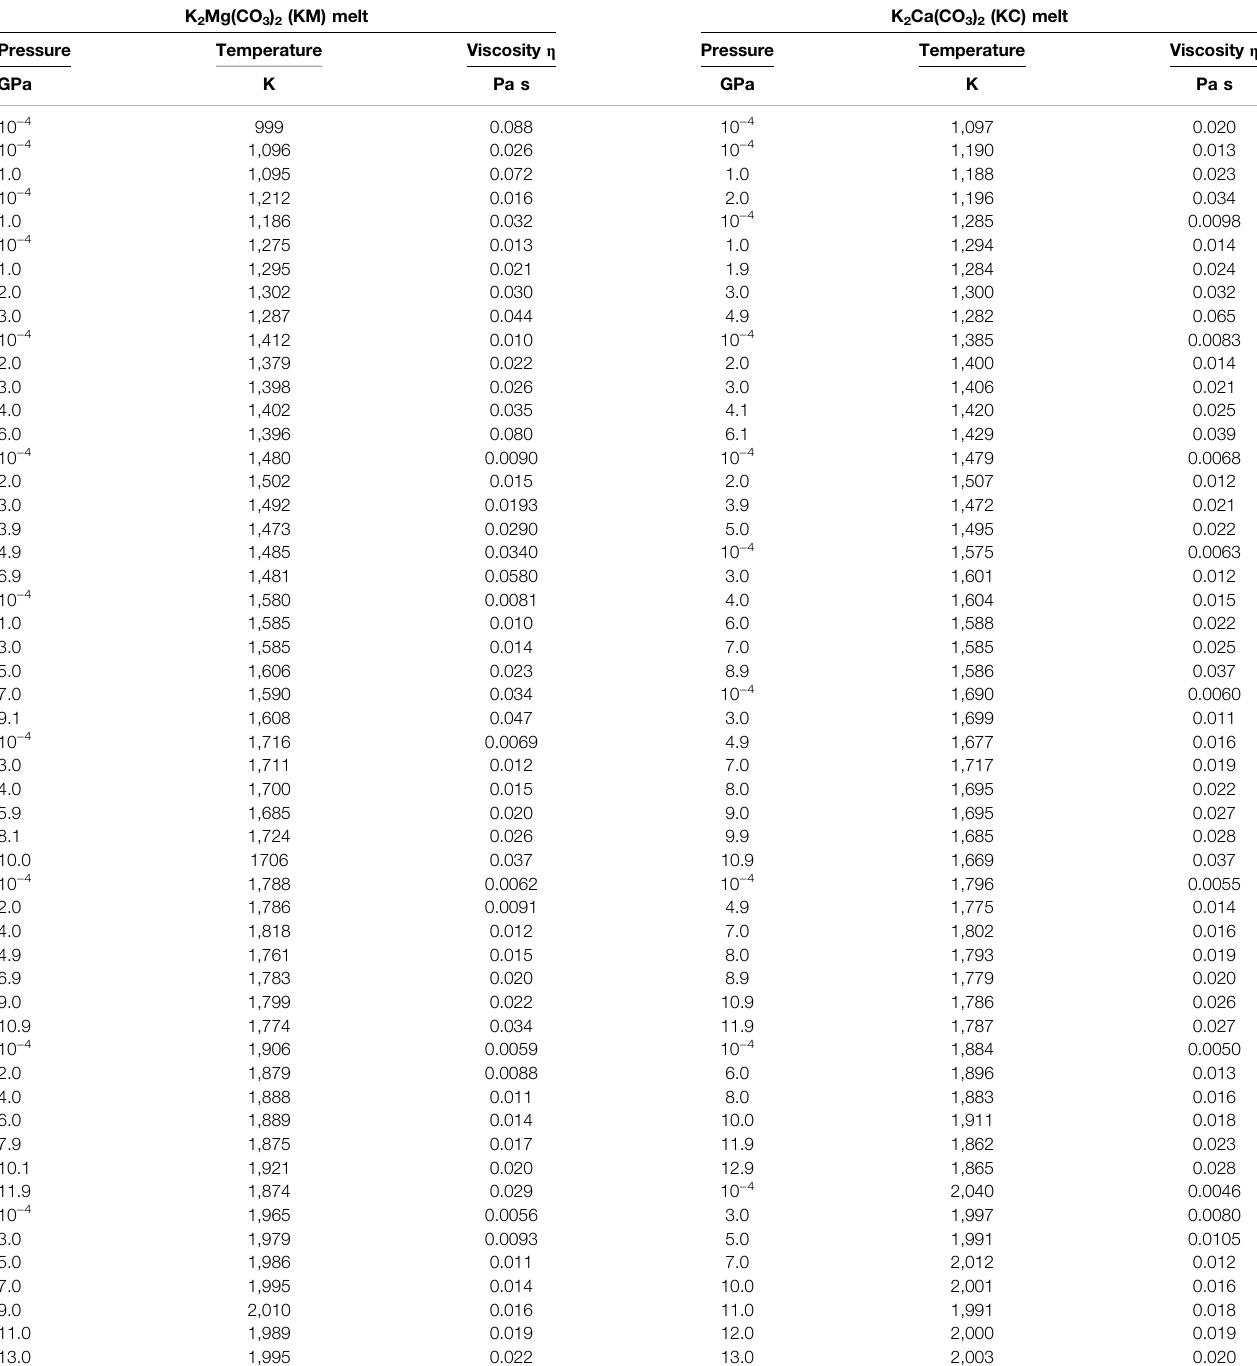
TABLE 2 | Viscosities ofK 2 Mg(CO 3 ) 2 and K 2 Ca(CO 3 ) 2 melts computed in the NVE ensemble as a function ofpressure and temperature conditions. Uncertainty for pressure and temperature are ± 0.5 GPa and 1%, repectively. Uncertainties in viscosity are typically ± 15% up to 1,800 K and ca. ± 40% at higher temperatures. K 2 Mg(CO 3 ) 2 (KM)